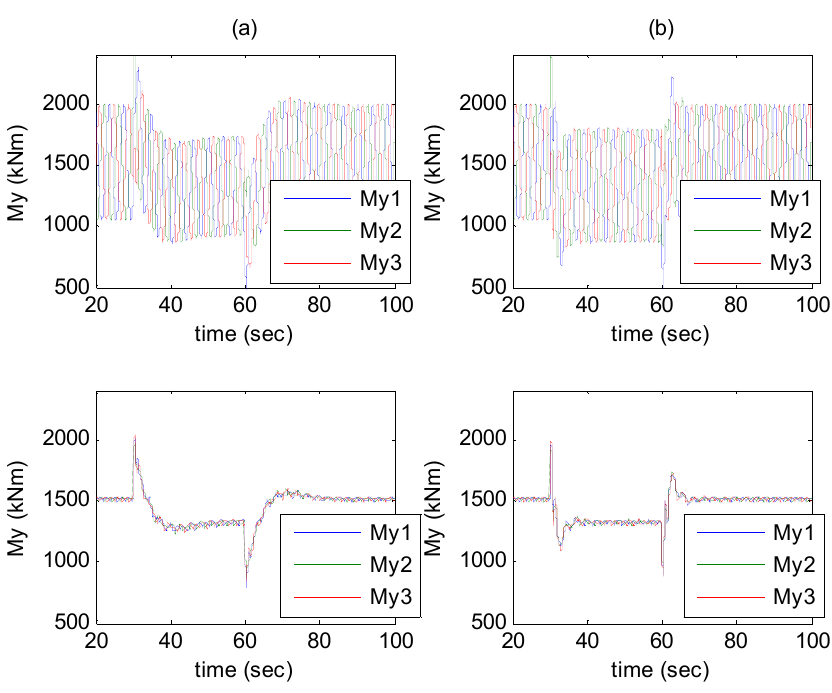
Figure 8. Responses of blade bending moments (without IPC (top) and with IPC (bottom)): ( a ) more weighting on blade moment; ( b ) more weighting on rotor